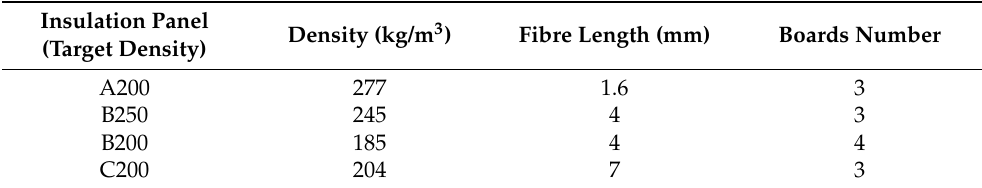
Table 1. Experimental design of bark fibre boards with three fibre bundle lengths (1.6, 4, and 7 mm) and two density levels (200 and 250 kg/m 3 ).